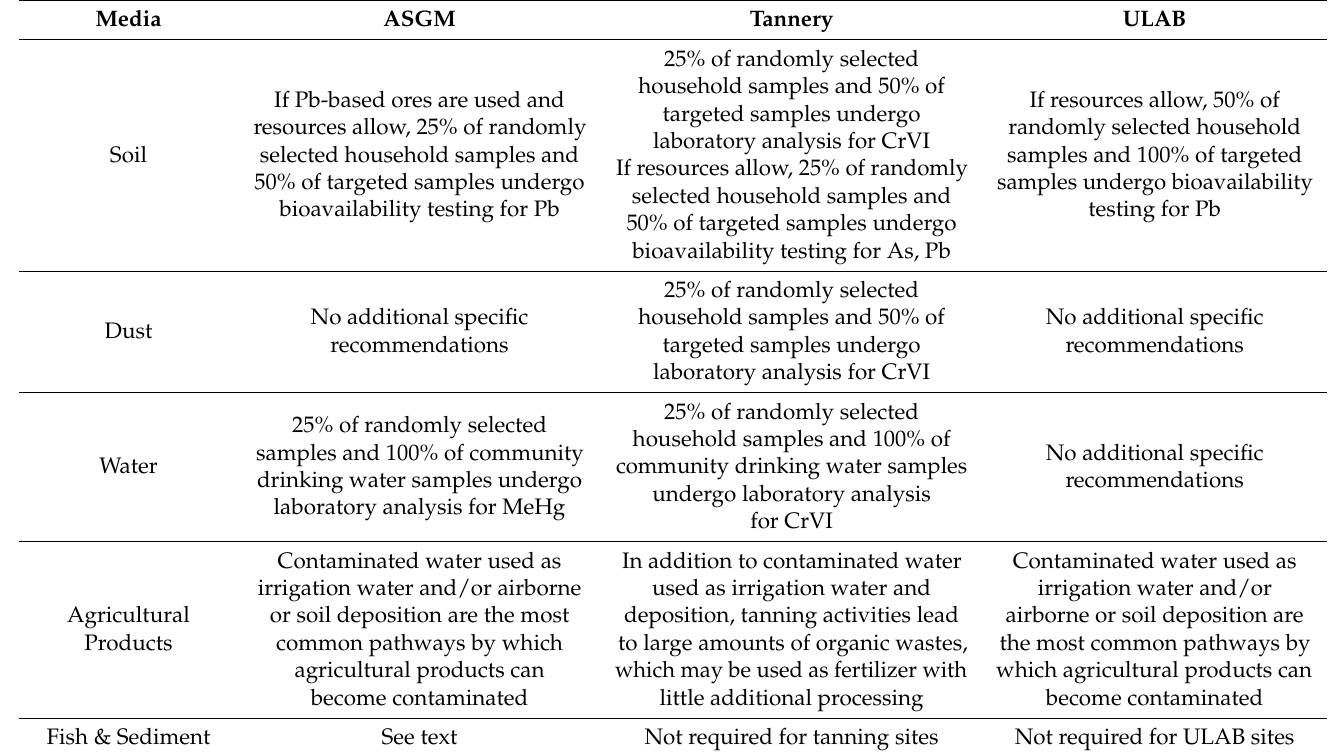
Table 2. Overview of sector-specific sampling guideline